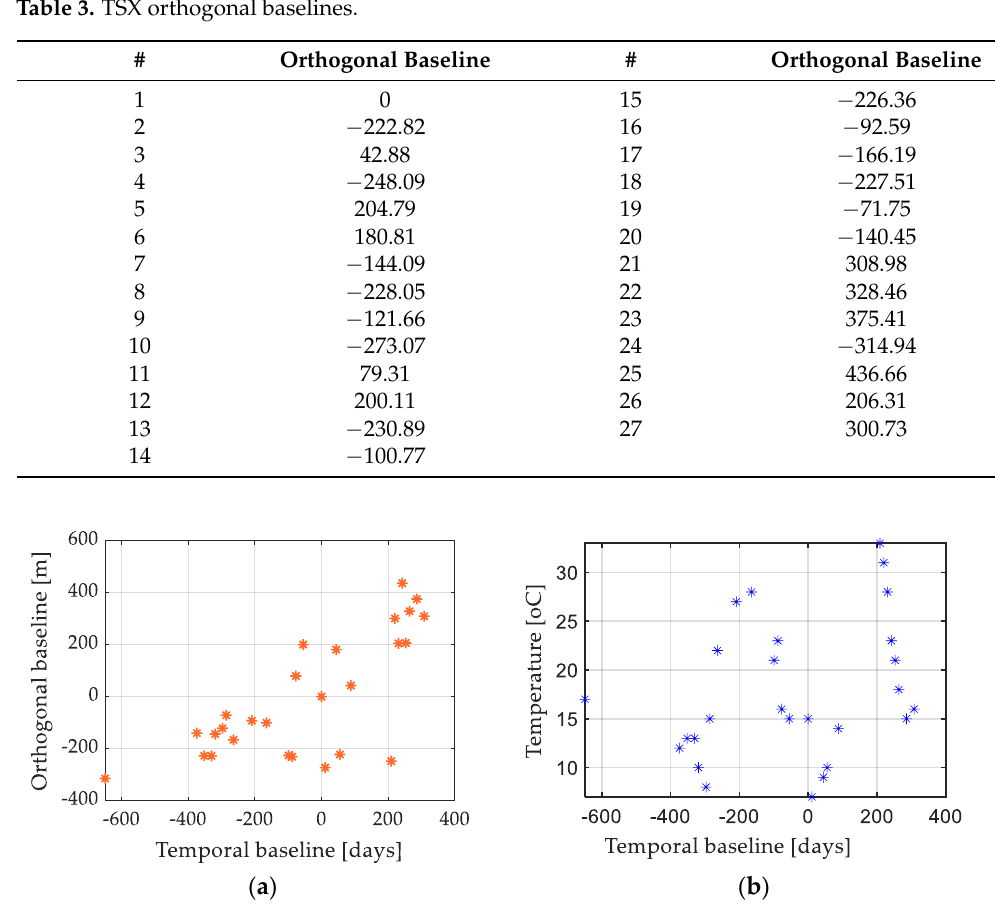
Figure 2. Baselines ’ distribution for TSX data: ( a ) Distribution of orthogonal vs. temporal baselines; ( b ) Distribution of temperature versus temporal baselines.